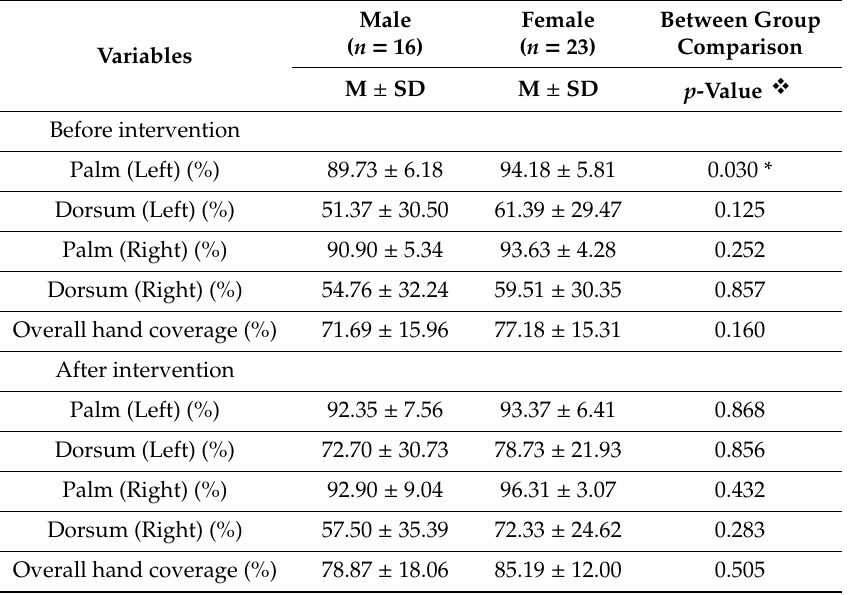
Table 2. Within-group and between-group comparisons of hand coverage (%) using hand sanitizer.